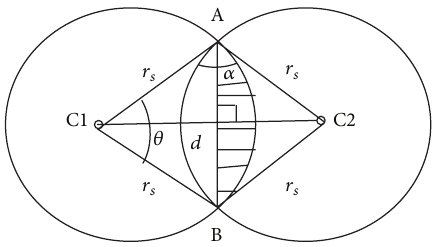
Figure 2: Illustration of the calculation of the overlapped coverage of nodes C1 and